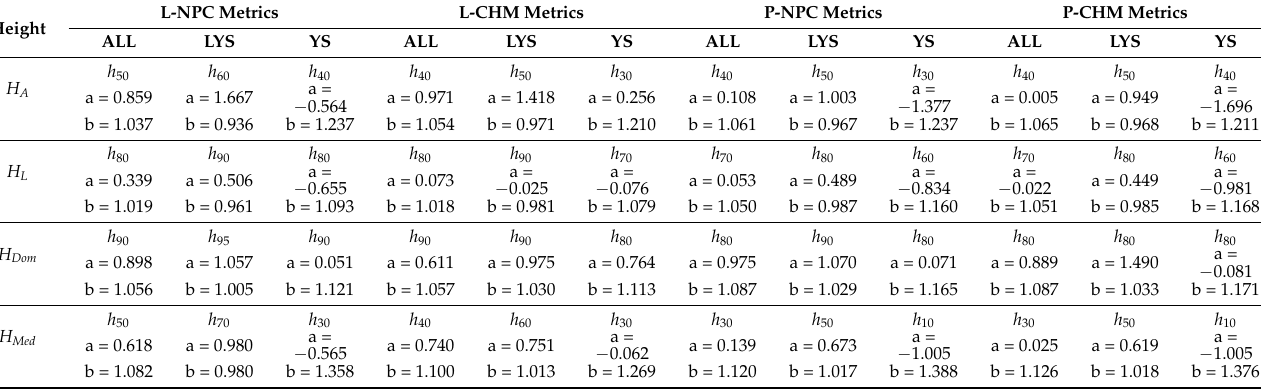
Table A2. The explanatory variables and parameters of different forest stand heights from the ULS and USP